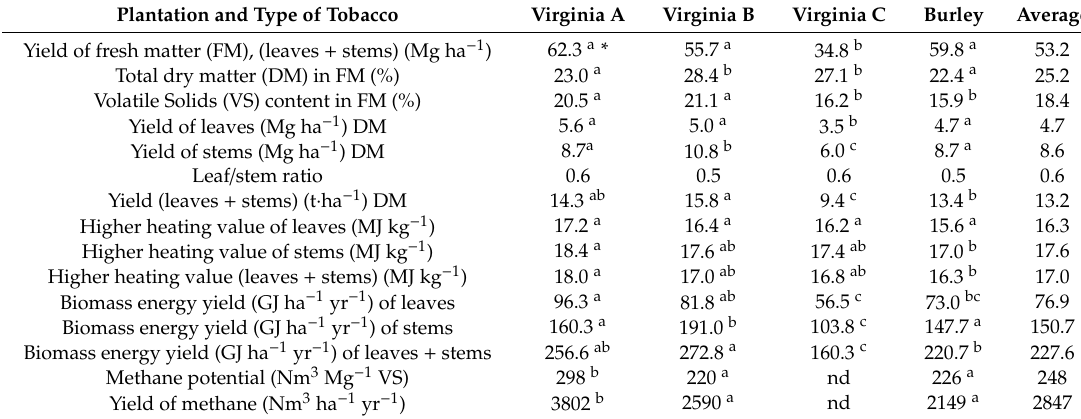
Table 3. Yields and properties of the tested tobacco